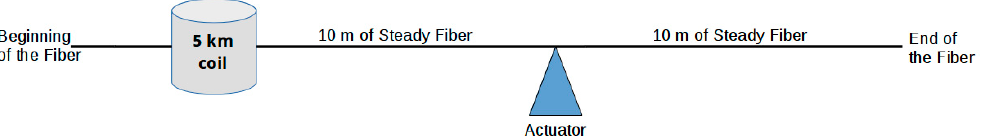
Figure 8. TIA output of a 5-km (about 5003 m) long coil fiber with an extra 20-m fiber used for the measurement. The trace time variable on the x-axis is converted to fiber length through Equation (15).